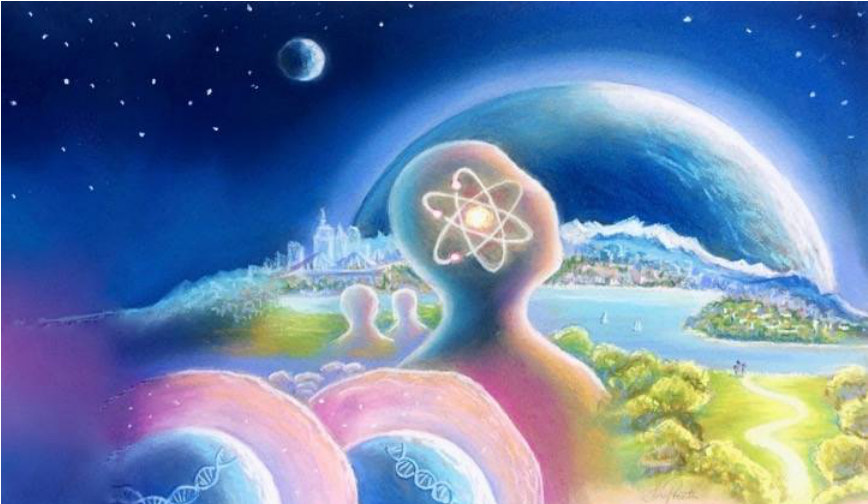
Figure 1. The importance of wisdom for flourishing of people, places, and planet: Jonas Salk underscored wisdom as a primary asset for transforming health of all interdependent systems—from cellular biology to the sociocultural ecology that affects all life on our planet. Wise choices not only change our future, but who we are right now (artwork by S.L.P.).